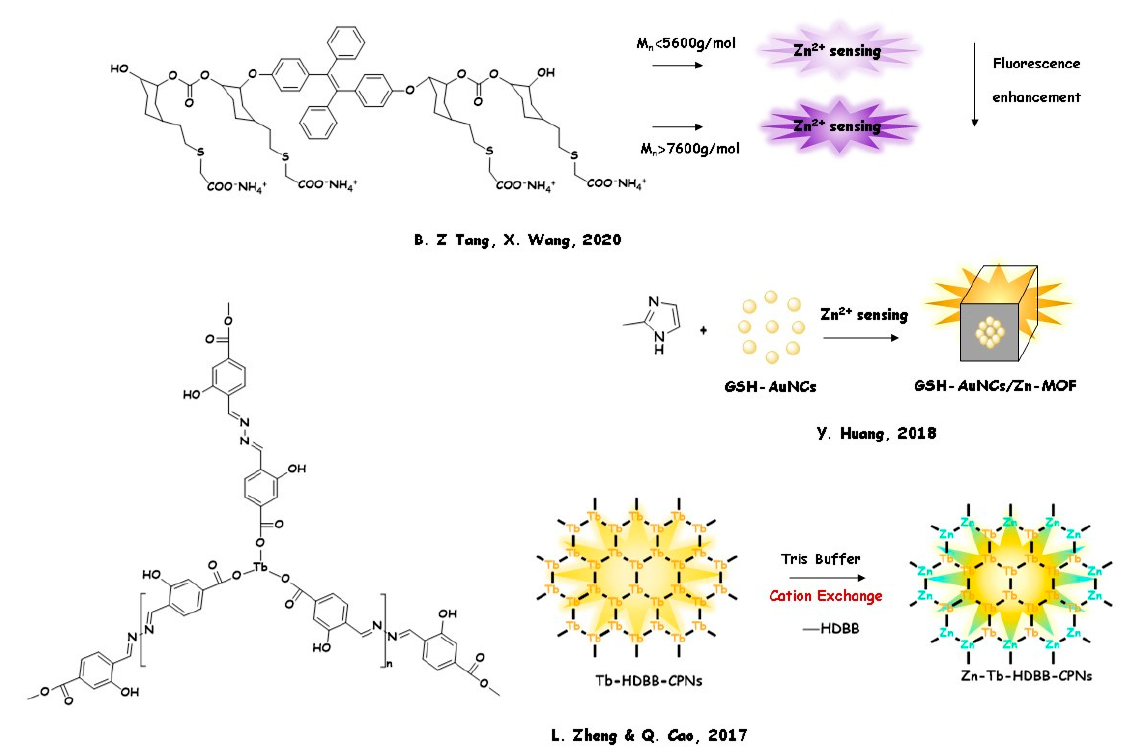
Figure 6. Macro-structured AIEgens acting as zinc (II) sensor.